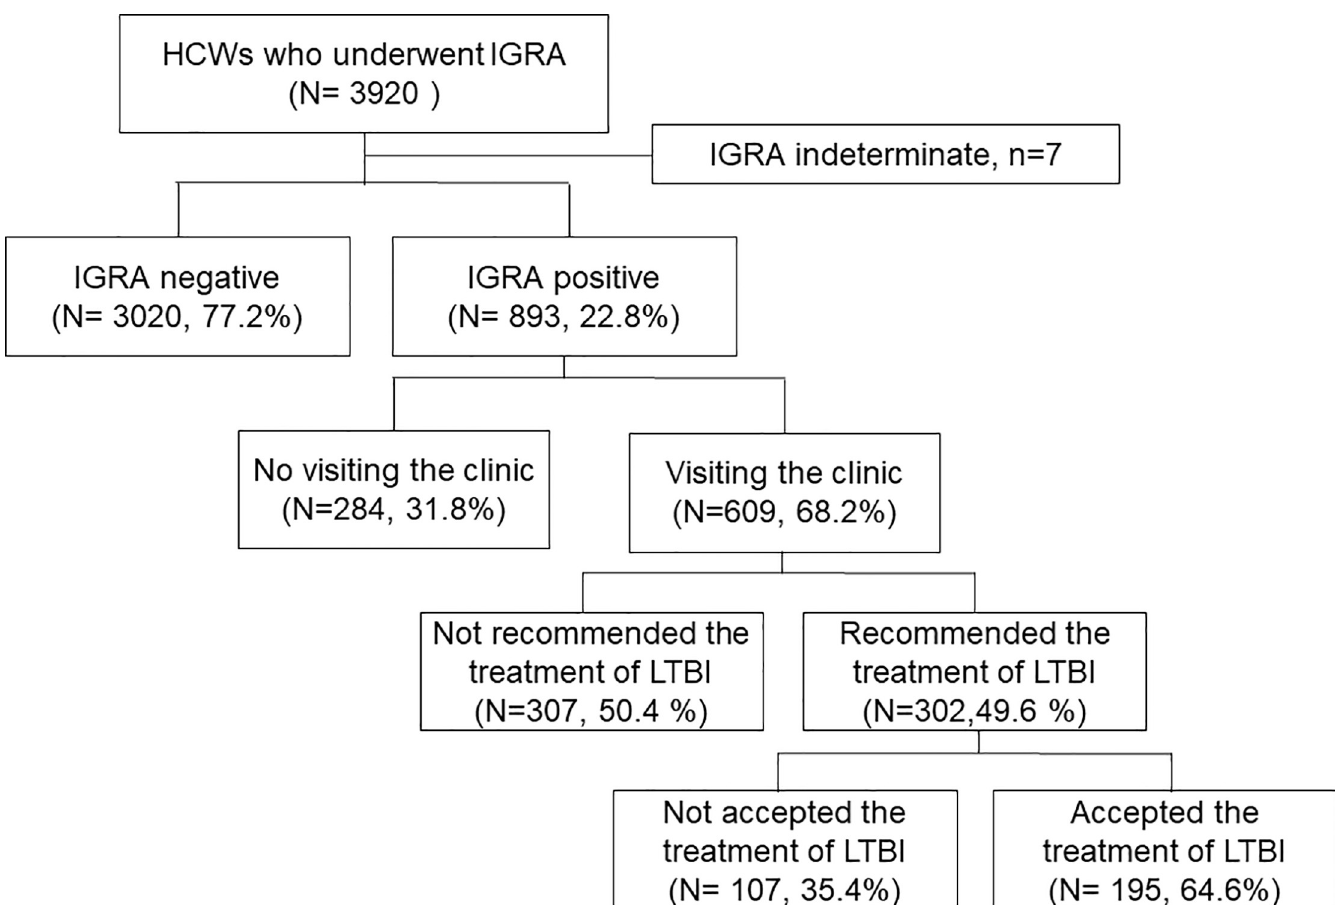
Fig 1. Flow chart of the study. HCWs, health care workers; IGRA, interferon-gamma release assay; LTBI, latent tuberculosis infection.